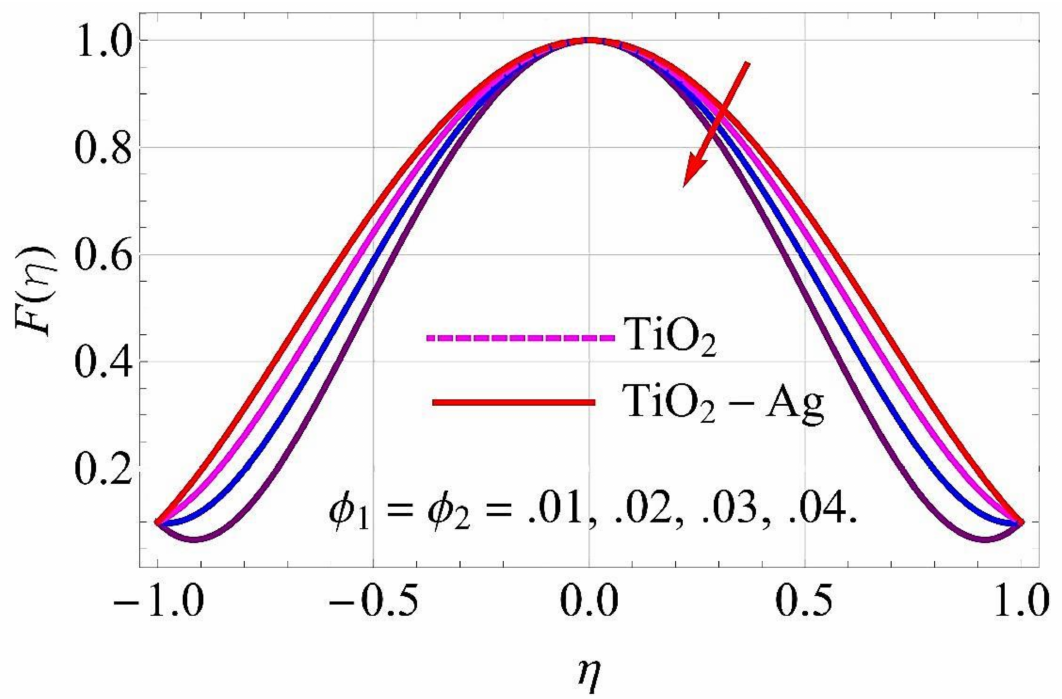
Figure 3. Velocity versus φ 1 , φ 2 with α = − 5 ◦ , for converging/stretching circumstances. When Re = 25, Rd = 0.4, Ec = Ha = Q = Fr = k ∗ = K 1 = 0.1.